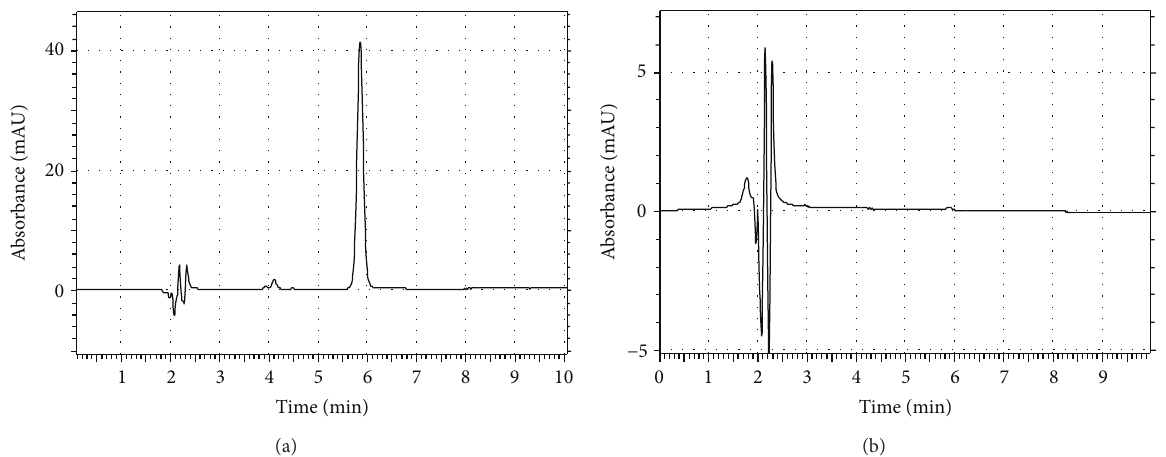
Figure 5: A chromatogram obtained from analyzing the commercially available gel. The solution contains the target diltiazem concentration of 9.35 𝜇 g/mL. (b) blank.